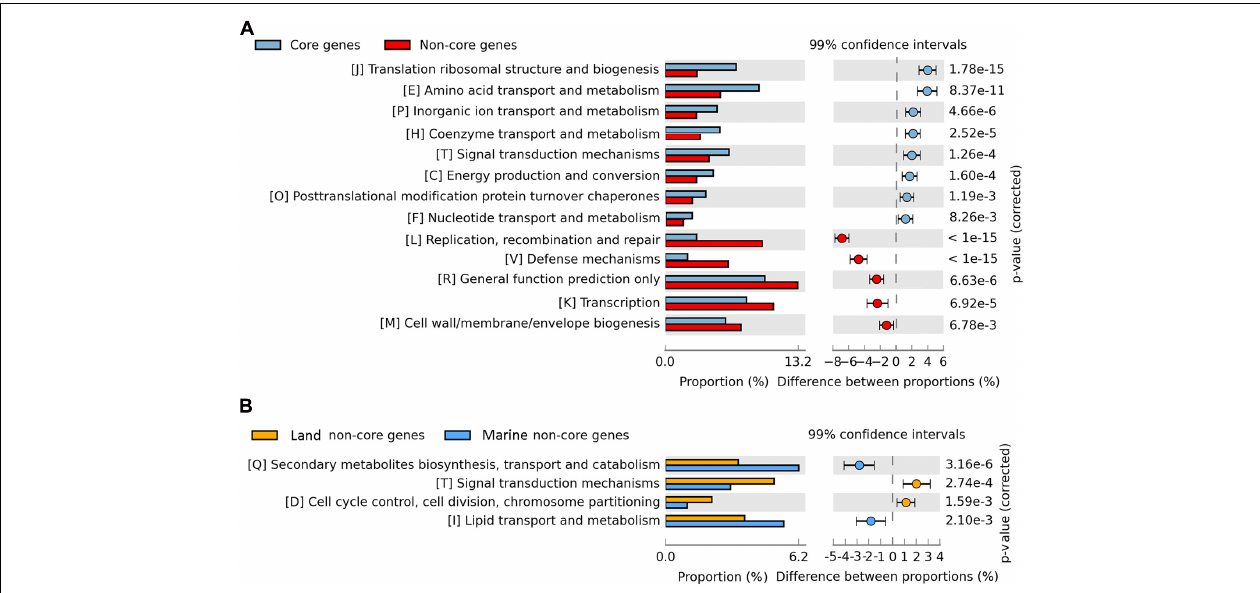
FIGURE 5 | COG categories for total strains and marine vs. land strains. (A) COG categories of core genes and non-core genes. Blue represents core genes; red represents non-core genes. (B) Non-core gene COG categories of marine isolated strains and land isolated strains. Blue represents marine isolated strains; red represents land isolated